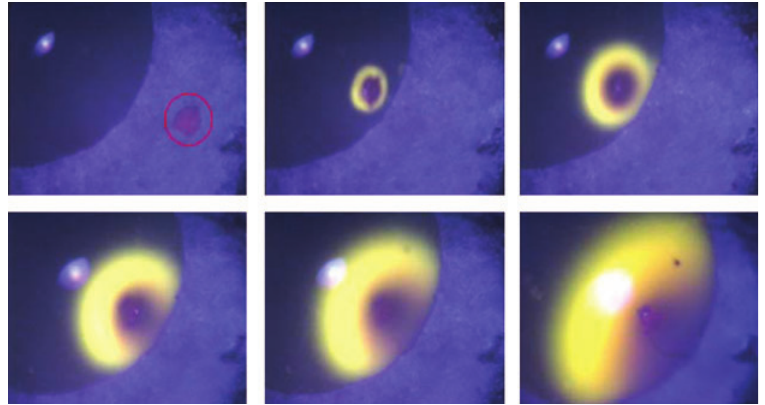
Figure 16 Fluorescence microscope images monitoring the dissolution of rhodamine microcrystallite in a droplet of water on a lemon tree leaf (excitation at 365 nm) ( Hake et al. 2007 ).